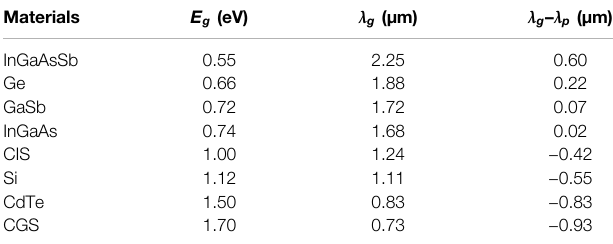
TABLE 2 | Different PV cell materials are compared. Materials